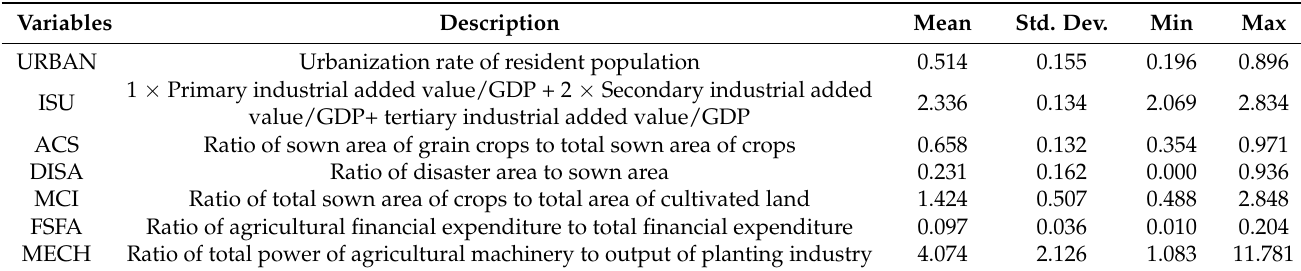
Table 3. Influencing factors of AEE